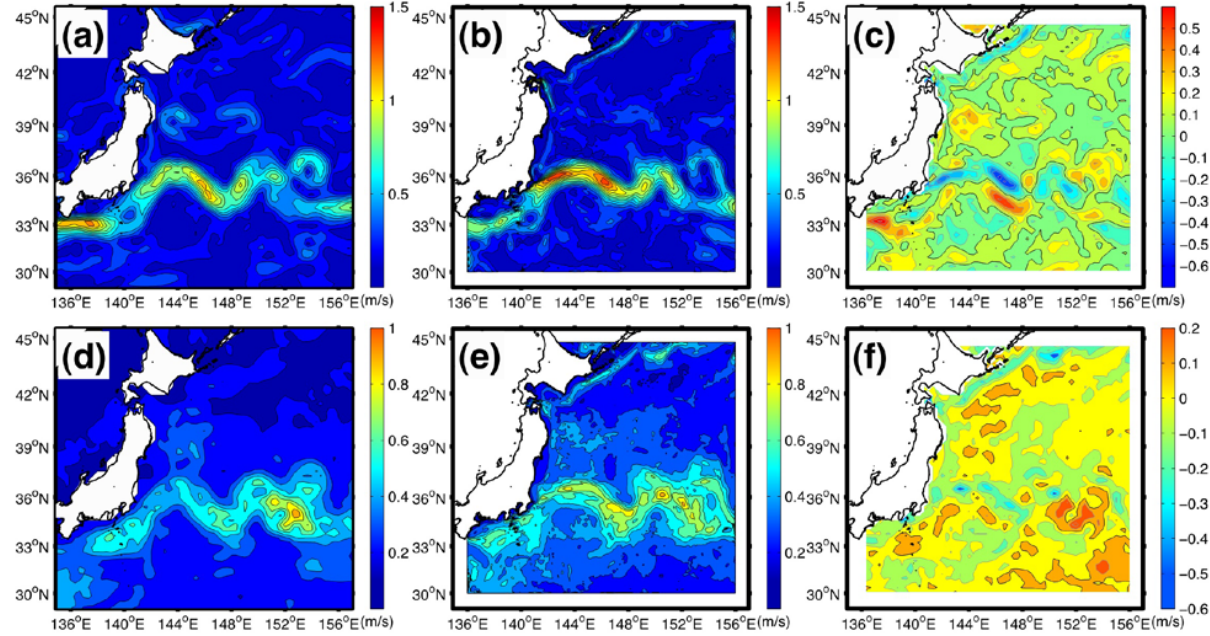
Fig. 3. (a) Time-mean currents for the observation-based model; (b) time-mean NCOM velocities averaged over the top 25 meters; (d) standard deviation of eddy velocities for the observation-based model; (e) standard deviation of eddy velocities for the NCOM model; (c, f) differences in means and standard deviations between the two models. (c) = (a) minus (b) and (f) = (d) minus (e). The period of data for this calculation is March 14, 2011 to July 31, 2011.